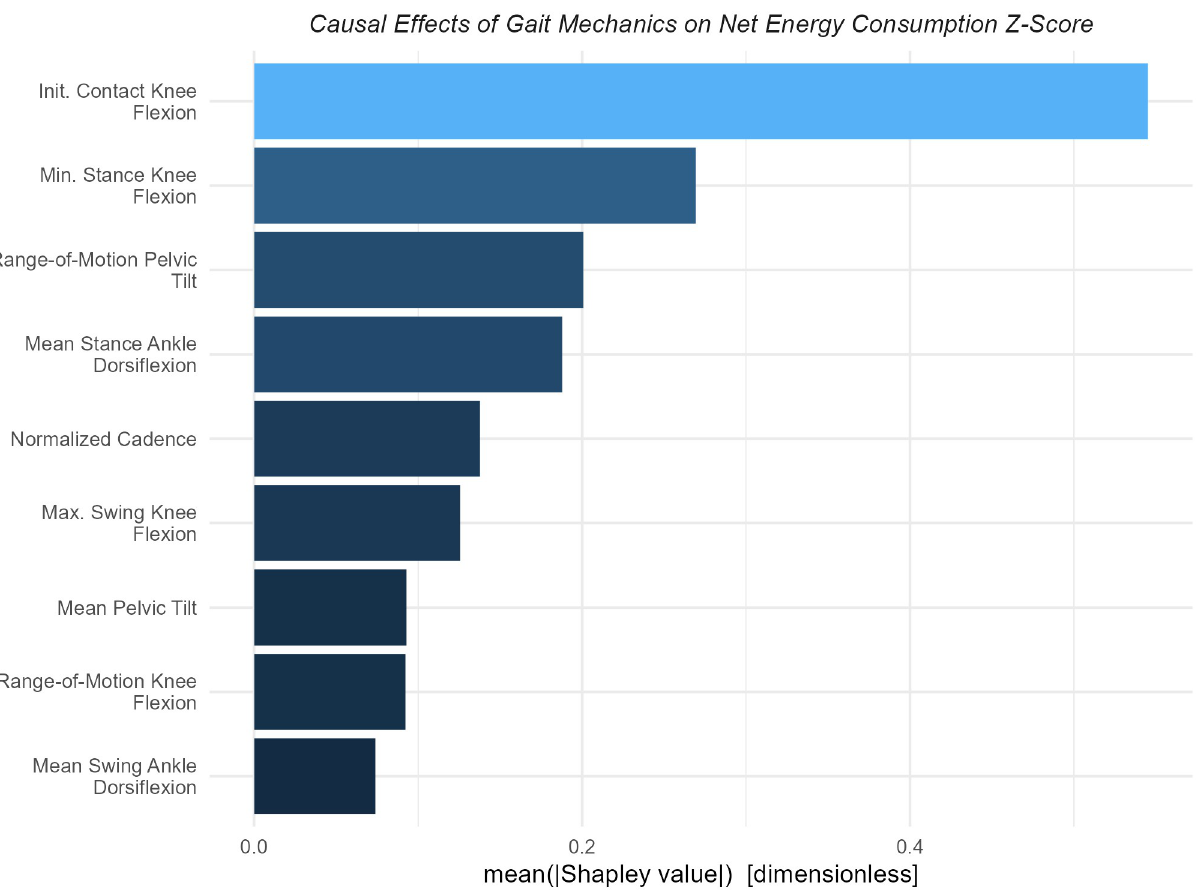
Fig 8. Importance of Gait Mechanics on net energy consumption. Knee flexion at initial contact has a causal impact twice as large as the next largest contributors, which are comprised of stance phase kinematic features of the knee and ankle.